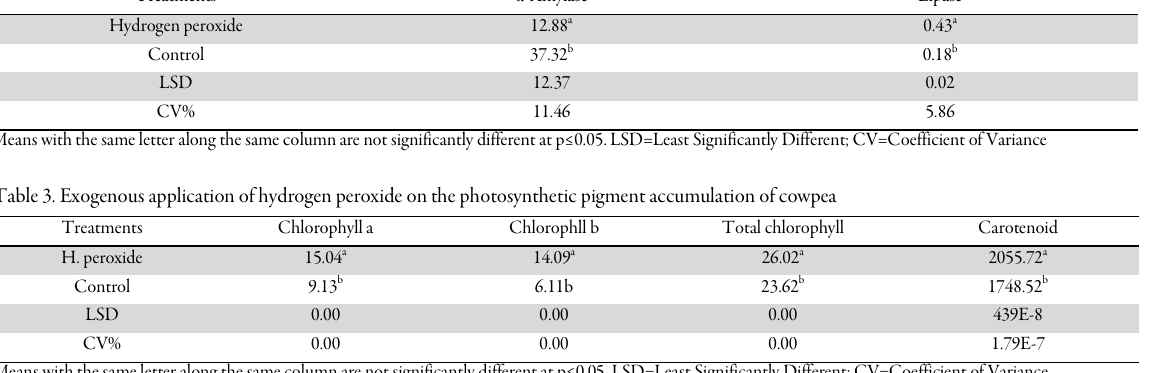
Table 2. Exogenous application of hydrogen peroxide on some enzyme activities in the leaf of cowpea Treatments